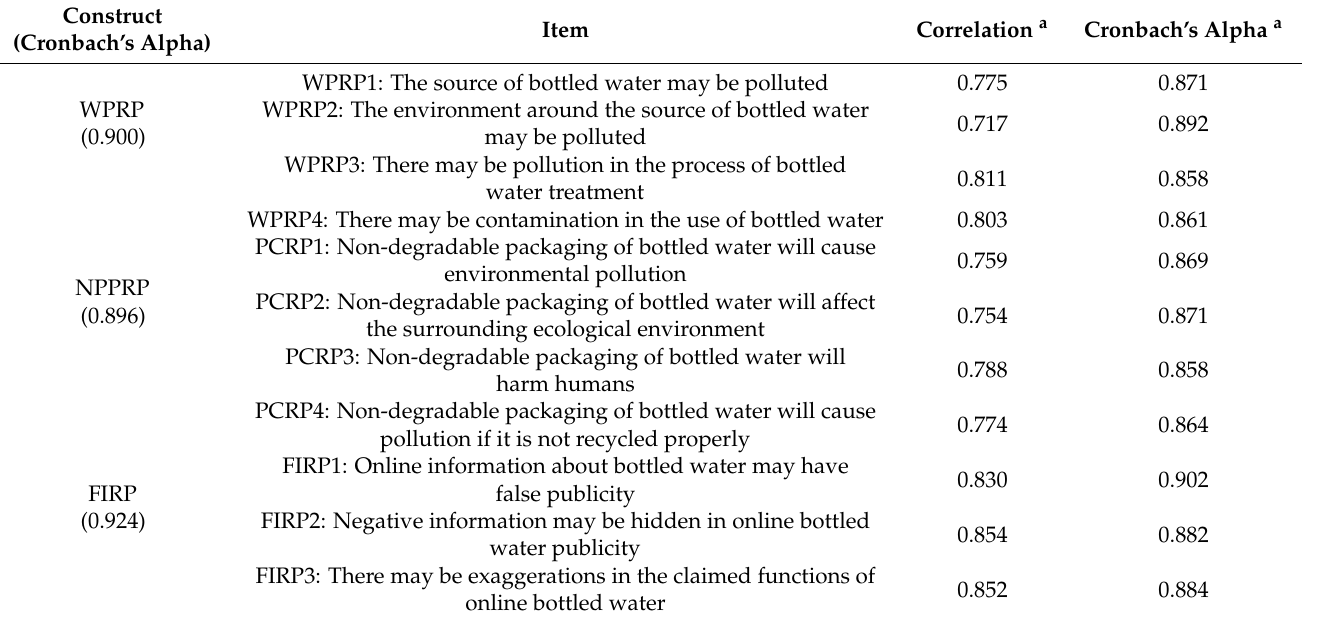
Table A1. Reliability test results of the pre-survey risk perception scale.